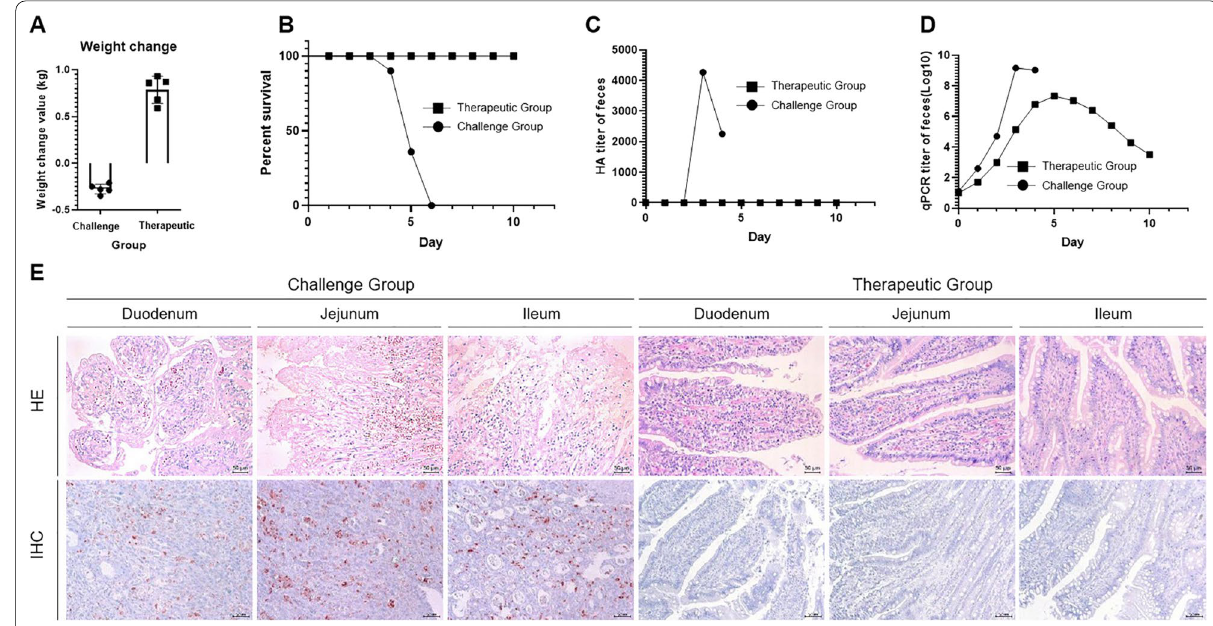
Fig. 7 Therapeutic efficacy of 11D9 in beagles. A Weight changes in different groups; B Survival rate of different groups; C and D The HA and qPCR test of the fecal samples from different groups to new CPV-2a; E Pathological results of HE and IHC in the challenge and therapeutic